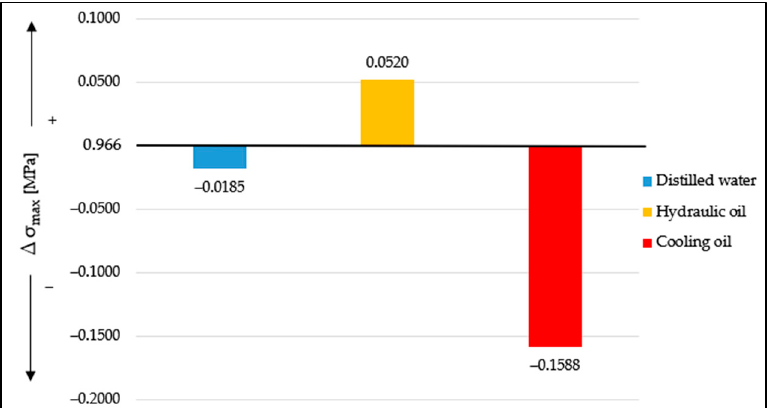
Figure 5. Comparison of the average of maximum values of tensile stress for Ecoflex 00-30 specimens for each liquid medium.